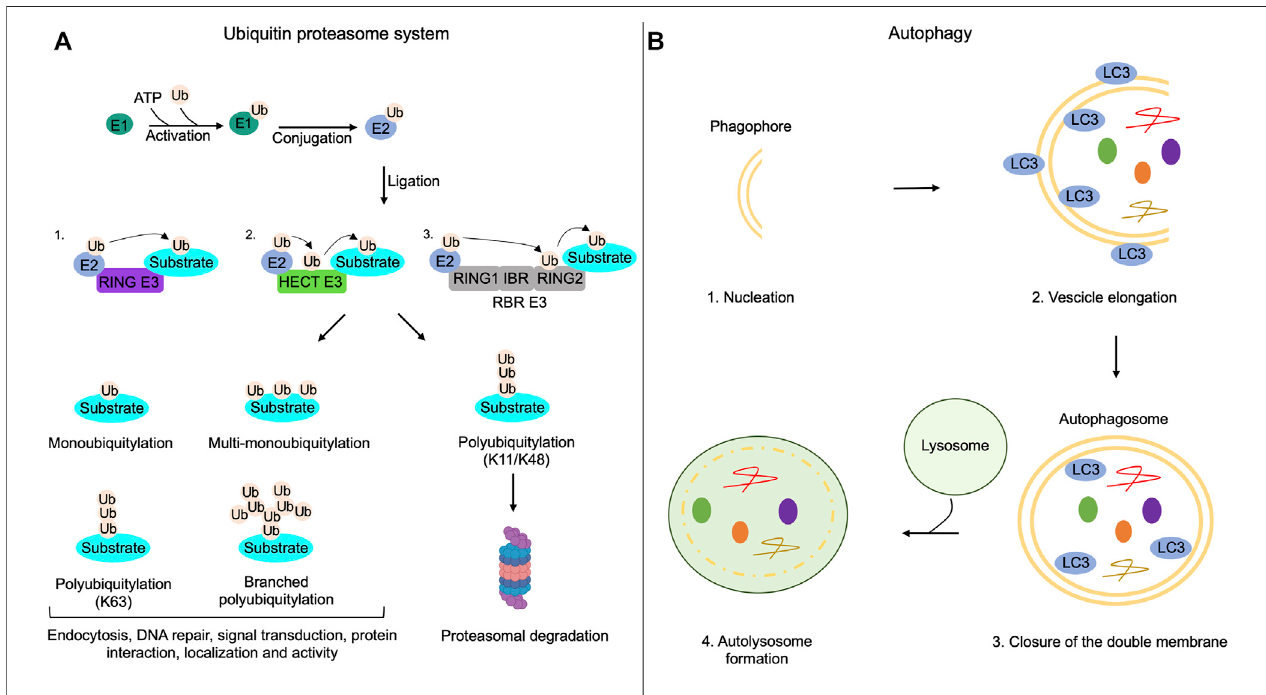
FIGURE 1 | Ubiquitin-proteasome system and autophagy mechanisms. (A) The addition of ubiquitin moieties to substrates occurs through three sequential enzymatic reactions: binding of ubiquitin to E1 enzymes in an ATP-dependent reaction (activation); transferring of ubiquitin to E2 enzymes (conjugation); covalent attachment of the ubiquitin moiety to the target substrate by E3 enzymes (ligation). RING-E3 ligases directly transfer ubiquitin from E2 enzymes to the substrate; HECT- E3 ligases bind ubiquitin and then transfer it to the substrate; RING between RING ligases (RBR) interact with E2, bind the ubiquitin on a cysteine residue of the RING domain and then transfer it to the substrates. Substrates of the UPS can be monoubiquitylated, multi-monoubiquitylated or polyubiquitylated. Polyubiquitylations can be characterized by the addition of linear or branched ubiquitin chains. Monoubiquitylations, multi-monoubiquitylations, branched polyubiquitylations and